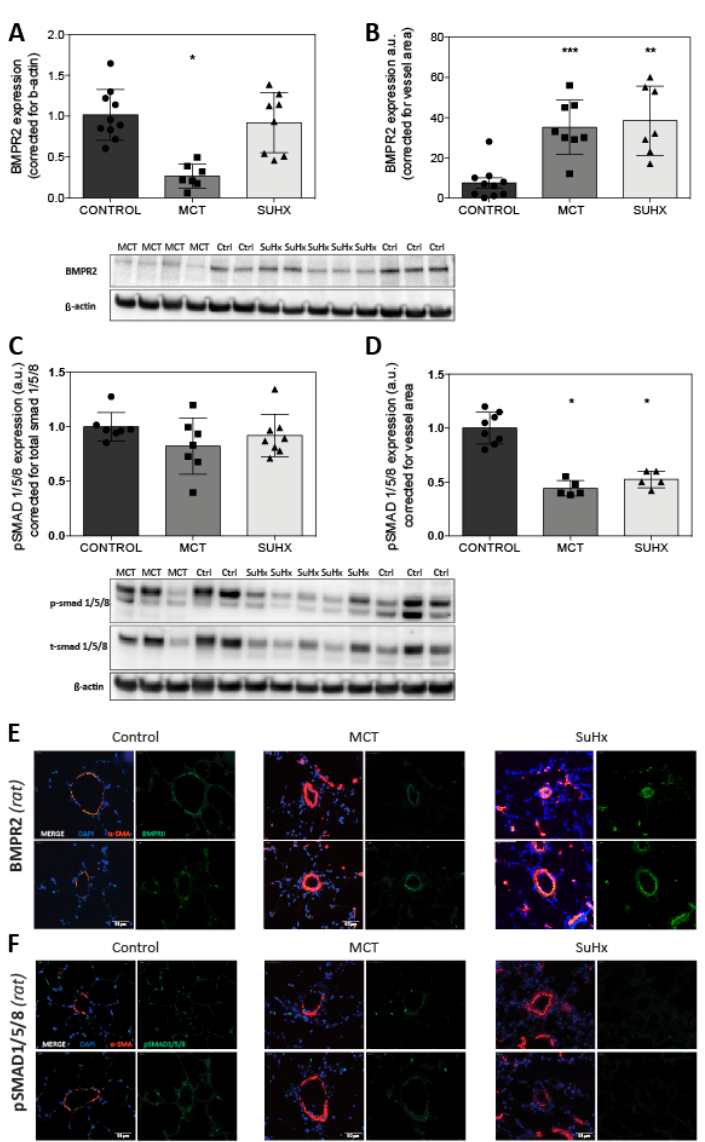
Figure 4. BMPR2 and pSmad 1/5/8 protein expression in the whole lung homogenates vs. immunofluorescence. ( A – B ): Analysis of the protein expression by Western blot; and ( C – D ): immunofluorescence. ( E ): Typical examples are shown. Green = pSmad 1/5/8 or BMPR2; red = smooth-muscle-actin ( α -SMA); blue = nuclei. Scale bar = 50 μ m. * = p < 0.05 / ** = p < 0.01 / ***= p < 0.001.